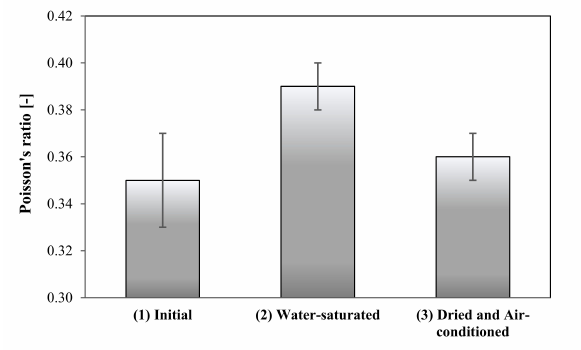
Figure 5: Poisson’s ratio of initial (dry), wet and dried epoxy speci- mens.